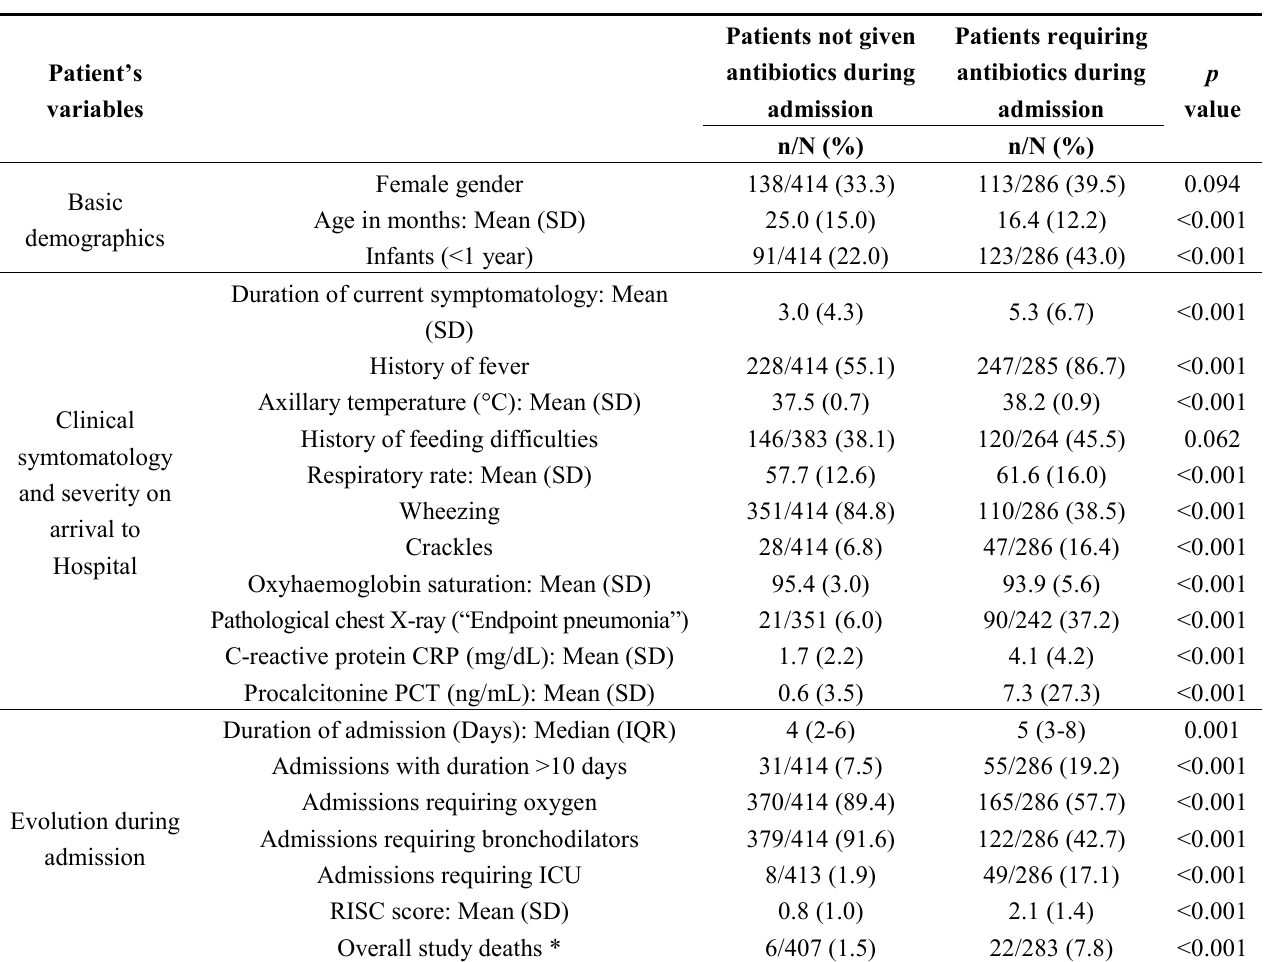
Table 3. Demographic, clinical, laboratory and outcome variables among patients recruited to the study according to antibiotic usage during